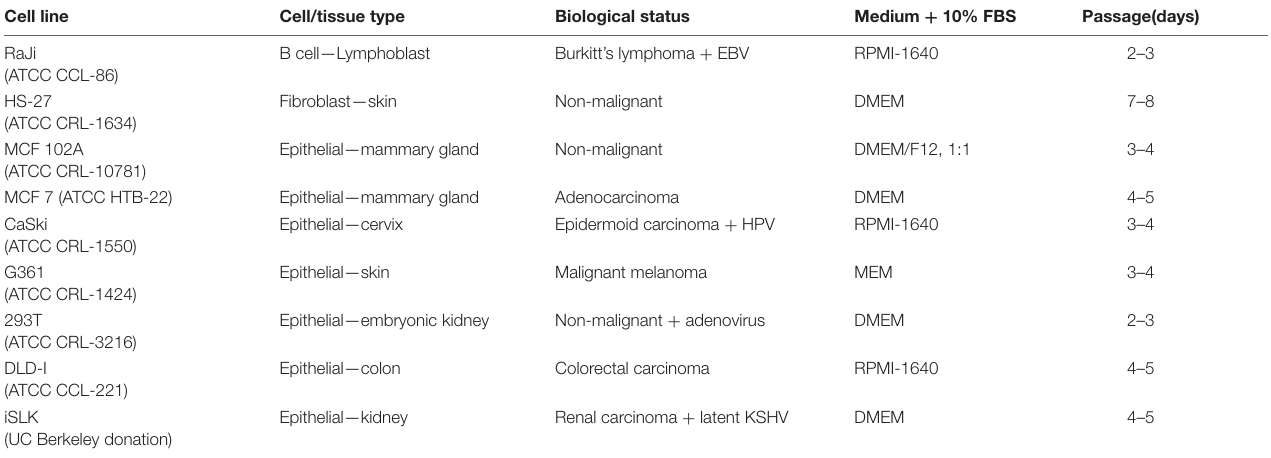
TABLE 1 | Cell lines used in in vitro infection experiments and growth conditions.